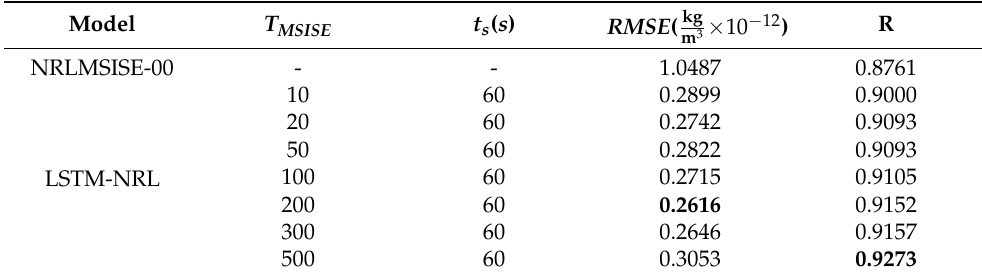
Table 2. The performance of the LSTM-NRL when changing T MSISE . It is noted that the best results, in terms of RMSE and R , are bold in the table.